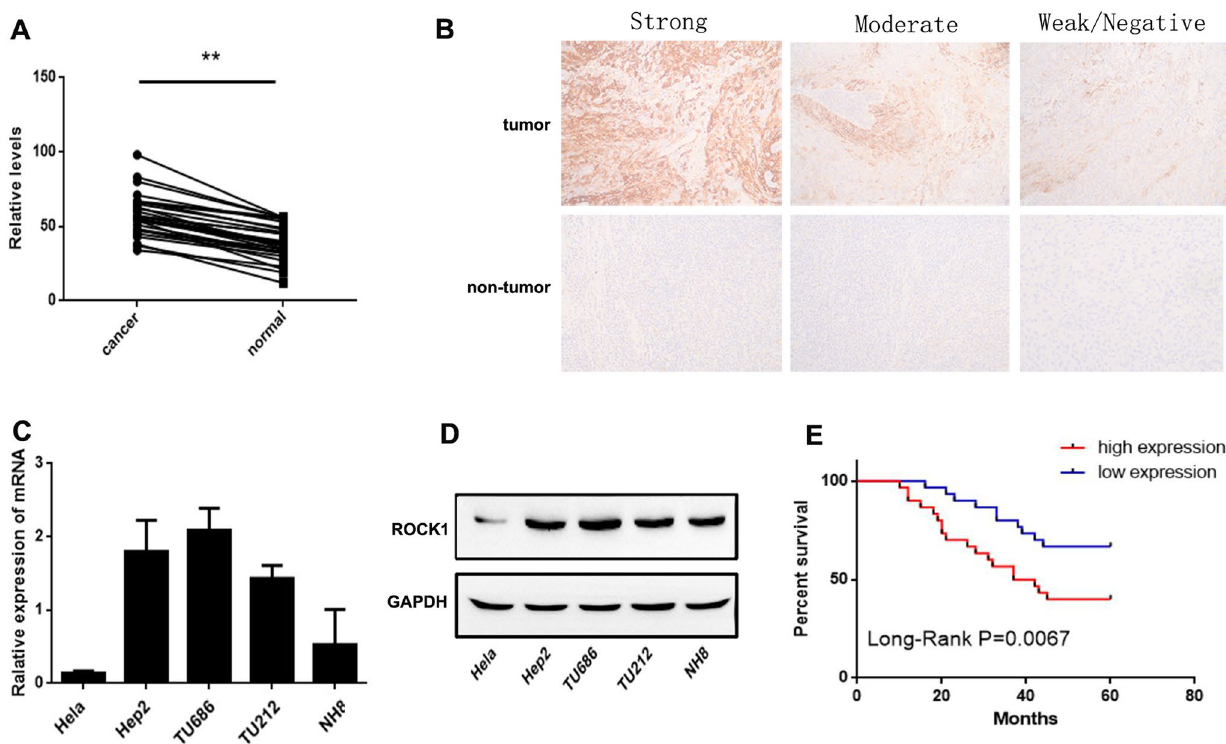
Fig. 1 ROCK1 overexpression in human LSCC tissues and cell lines. A The expression levels of ROCK1 mRNA in 30 LSCC were quantified by qRT-PCR. Data are shown as 2−∆Ct (**P < 0.01). B IHC staining of ROCK1 in LSCC tissues (magnification: ×100). C The mRNA expression of ROCK1 in the LSCC cell lines was quantified by qRT-PCR. D The protein expression of ROCK1 in human LSCC cell lines was examined by West- ern Blot. E Patients with ROCK1 weak staining had a significantly benign prognosis than those with strong staining, P = 0.0067